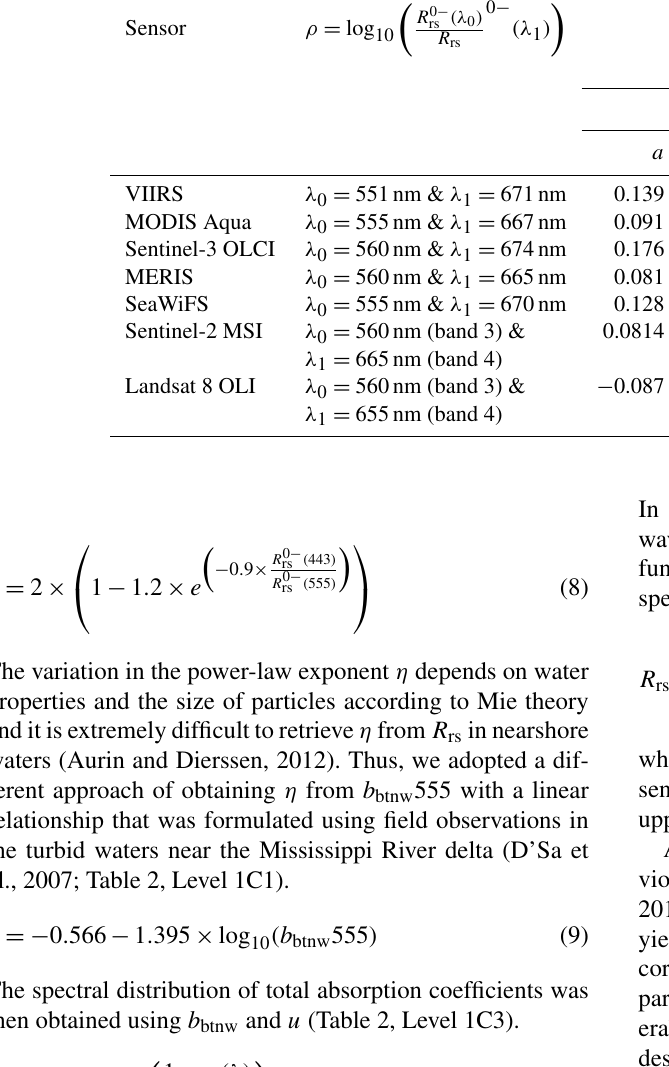
Table 3. The calibration coefficients for sensor-specific QAA tuning. λ 0 is a sensor-specific reference wavelength.